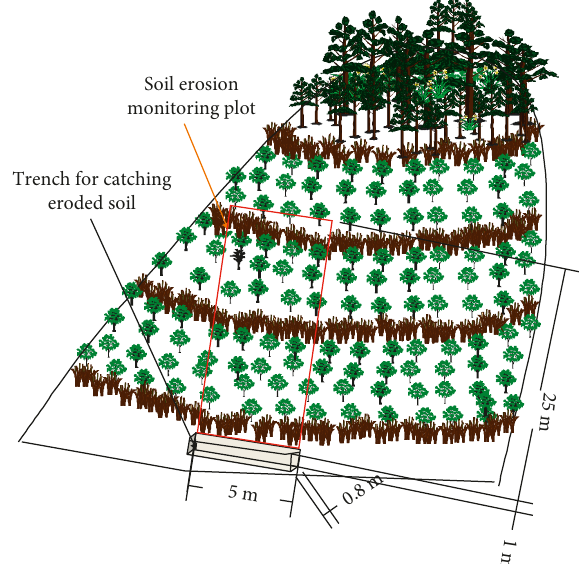
Figure 2: Designing a monitoring plot and caching eroded soil in the